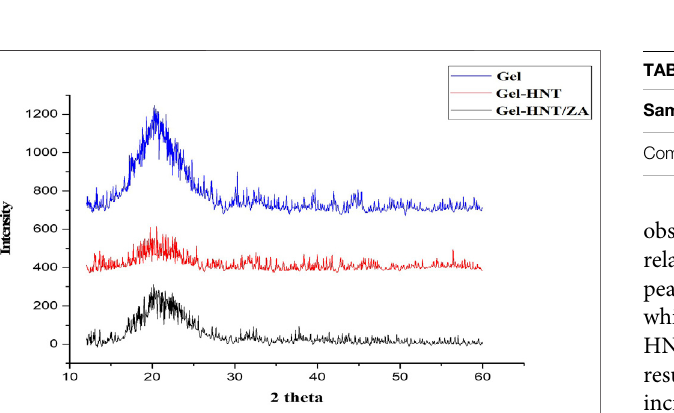
FIGURE 3 | The FTIR spectra of the Gel, Gel-HNT and Gel-HNT/ZA Scaffolds.